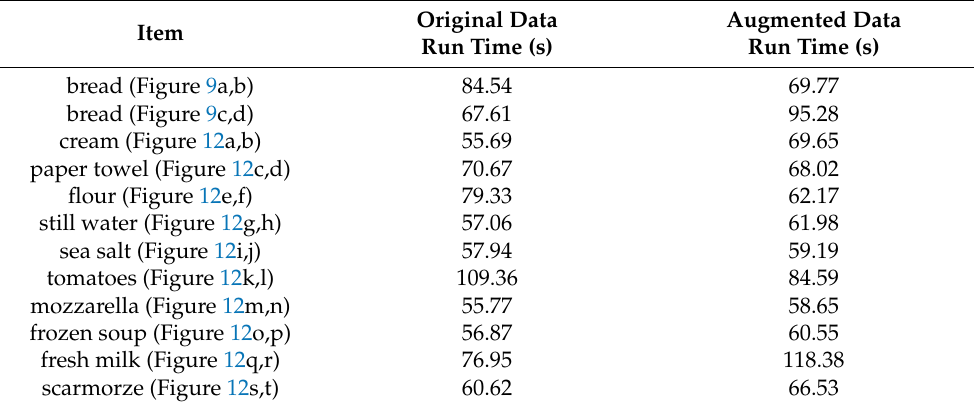
Table 5. Computational cost of the XGBoost model when trained with original or augmented data for various